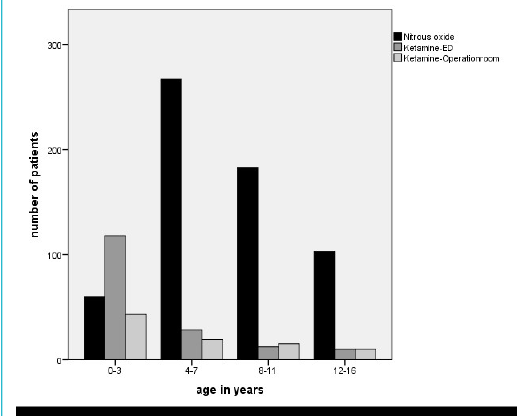
Figure 1: Procedural analgosedation in different age groups in 2016.Ketamine-ED: Intervention was performed by an ED physi- cian; Ketamine-OR: Intervention was performed in the operation room by a paediatric surgeon (potentially more severe cases).